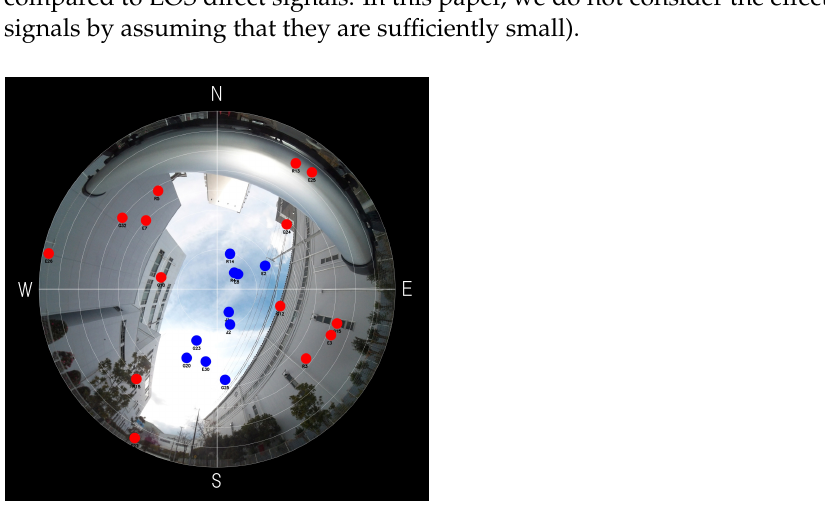
Figure 5. A fisheye-camera image taken at the place where we gathered data.